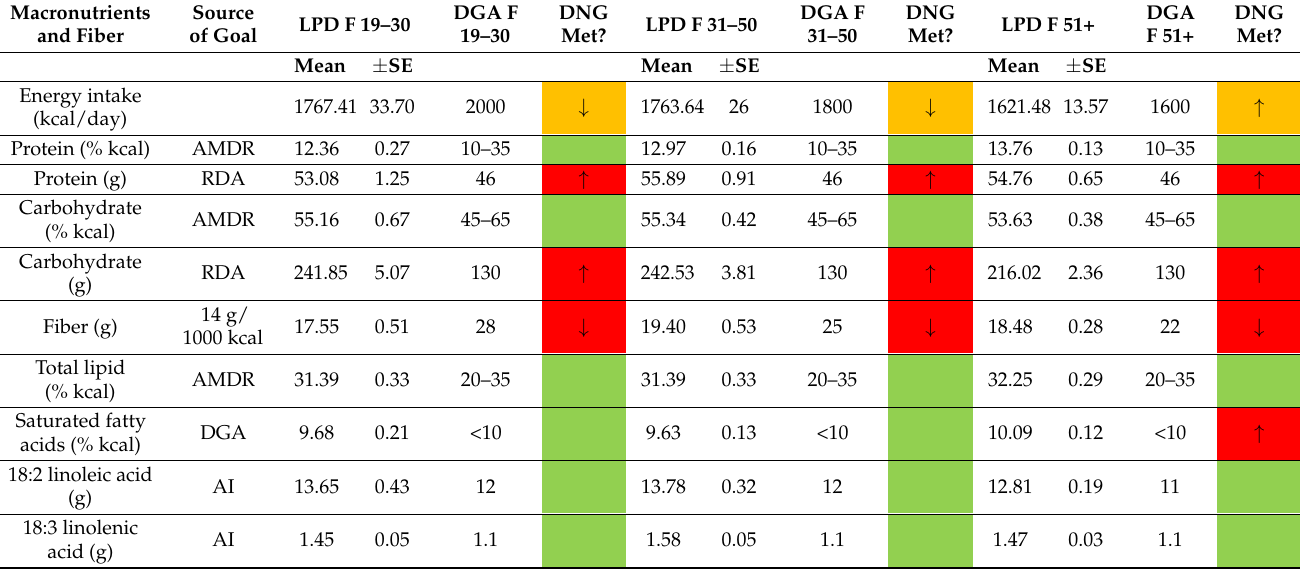
Table 3. Macronutrient and fiber intake in females following an LPD compared to the DNGs in the 2020–2025 DGA stratified by age